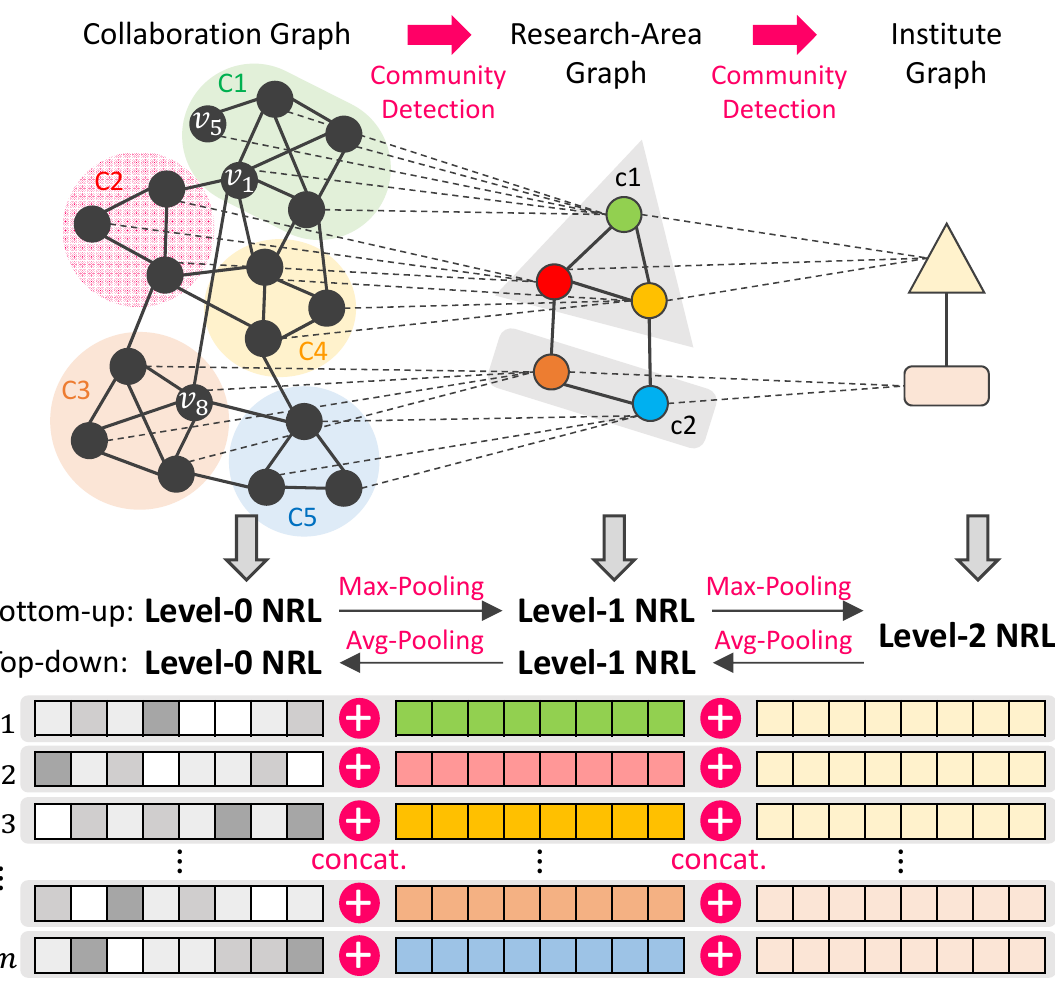
Figure 2. Overview of the proposed SHE